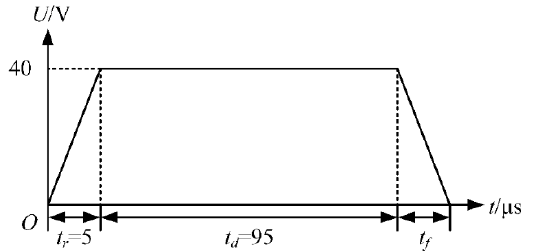
Figure 7. Trapezoidal waveform with a large value of t d .